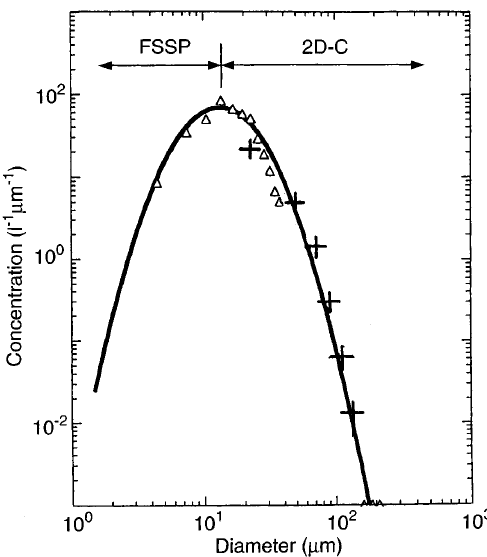
Fig. 5. Distribution of the ice particle size obtained over the North Sea during the ICE experiment. Crosses are relative to the 2D-C probe and triangles to the FSSP probe. The solid curve is the least square polynomial fit used in the radiative calculations